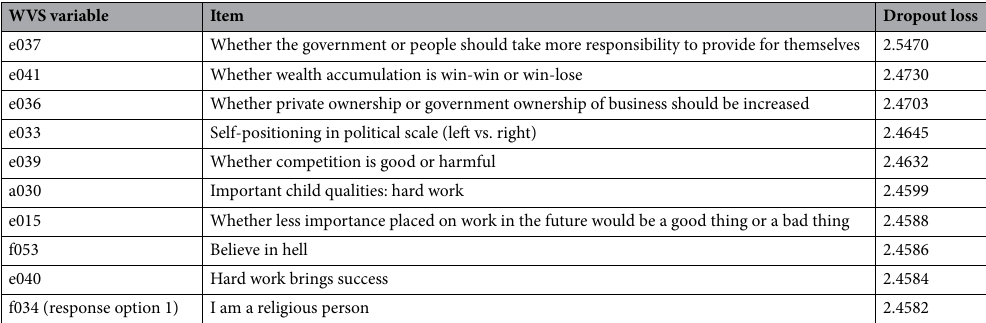
Table 2. Top 10 predictors of acceptance of income inequality based on the feature importance analysis. Dropout loss refers to the change in the model’s mean square error when the values ofthe relevant variable are